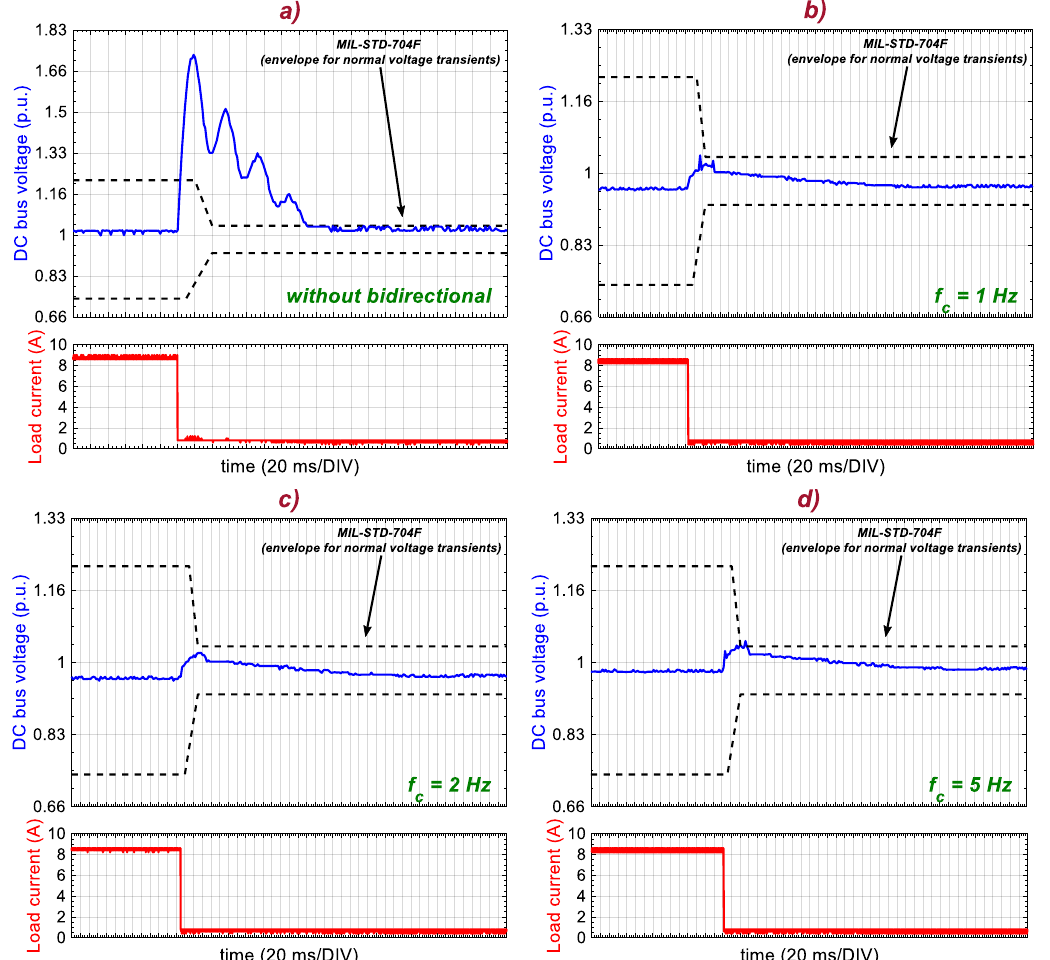
Figure 16. DC bus voltage response for a voltage swell, with the LPF cutoff frequency as a parameter, ( a ) without the proposed system; ( b ) f c = 1 Hz; ( c ) f c = 2 Hz; ( d ) f c = 5 Hz.